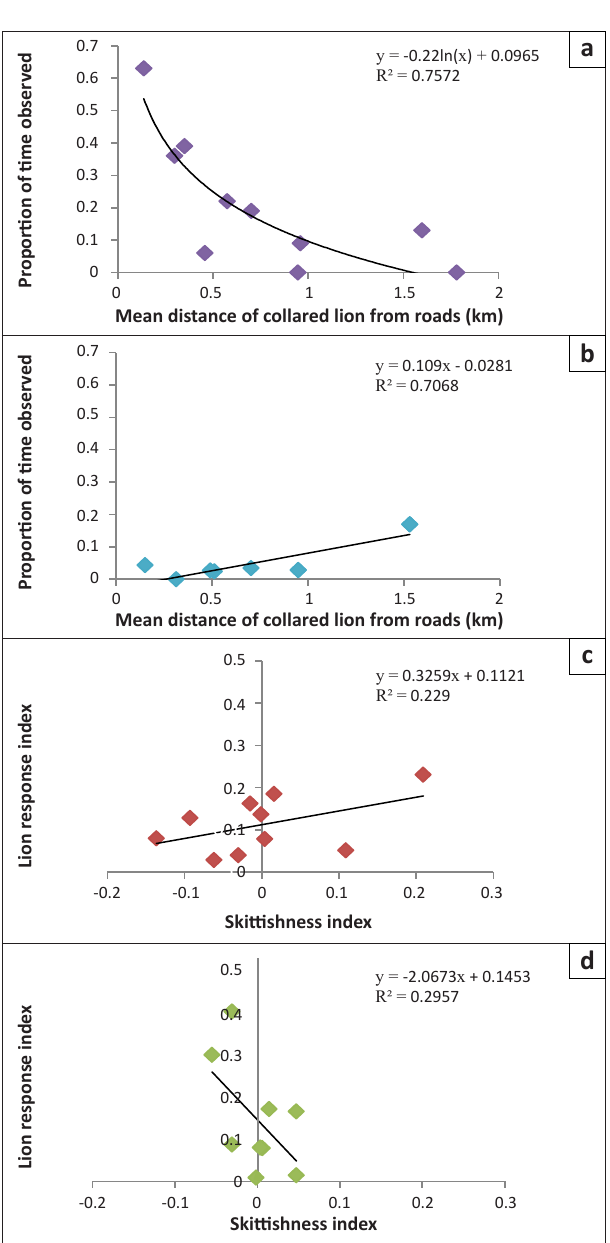
0 Number of people KNP; Kruger National Park. FIGURE 1: Lion response index in relation to the number of people present at a call-up site.